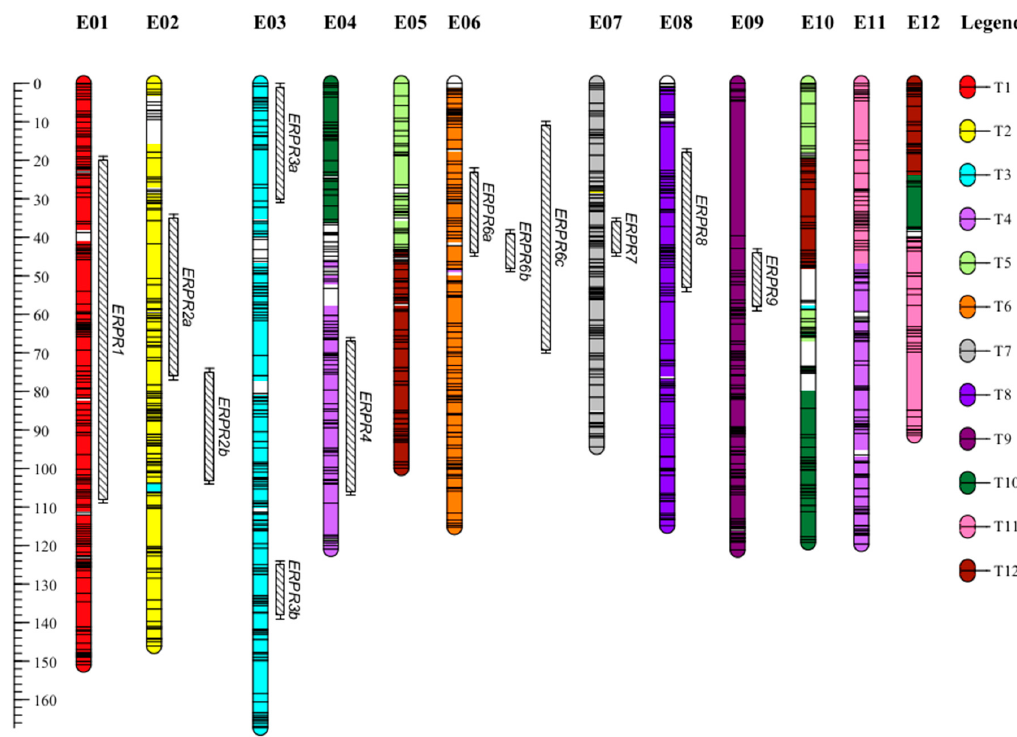
Figure 1. Genetic map of EG203 × MM738 doubled haploid population anchored on eggplant and tomato chromosomes. The figure shows the 12 linkage groups (LG)–chromosomes from E01 to E12 and their corresponding tomato chromosomes individualized by a color code (key on the right of the figure). The markers’ positions are symbolized by horizontal lines on the LG bars; the markers’ names were not included to facilitate map legibility. The list and positions of all markers can be found in Table S3. The detected quantitative trait loci (QTLs) and their confidence intervals are represented on the right of their respective chromosomes by black hatched bars, and their names are on the right of each QTL bar.